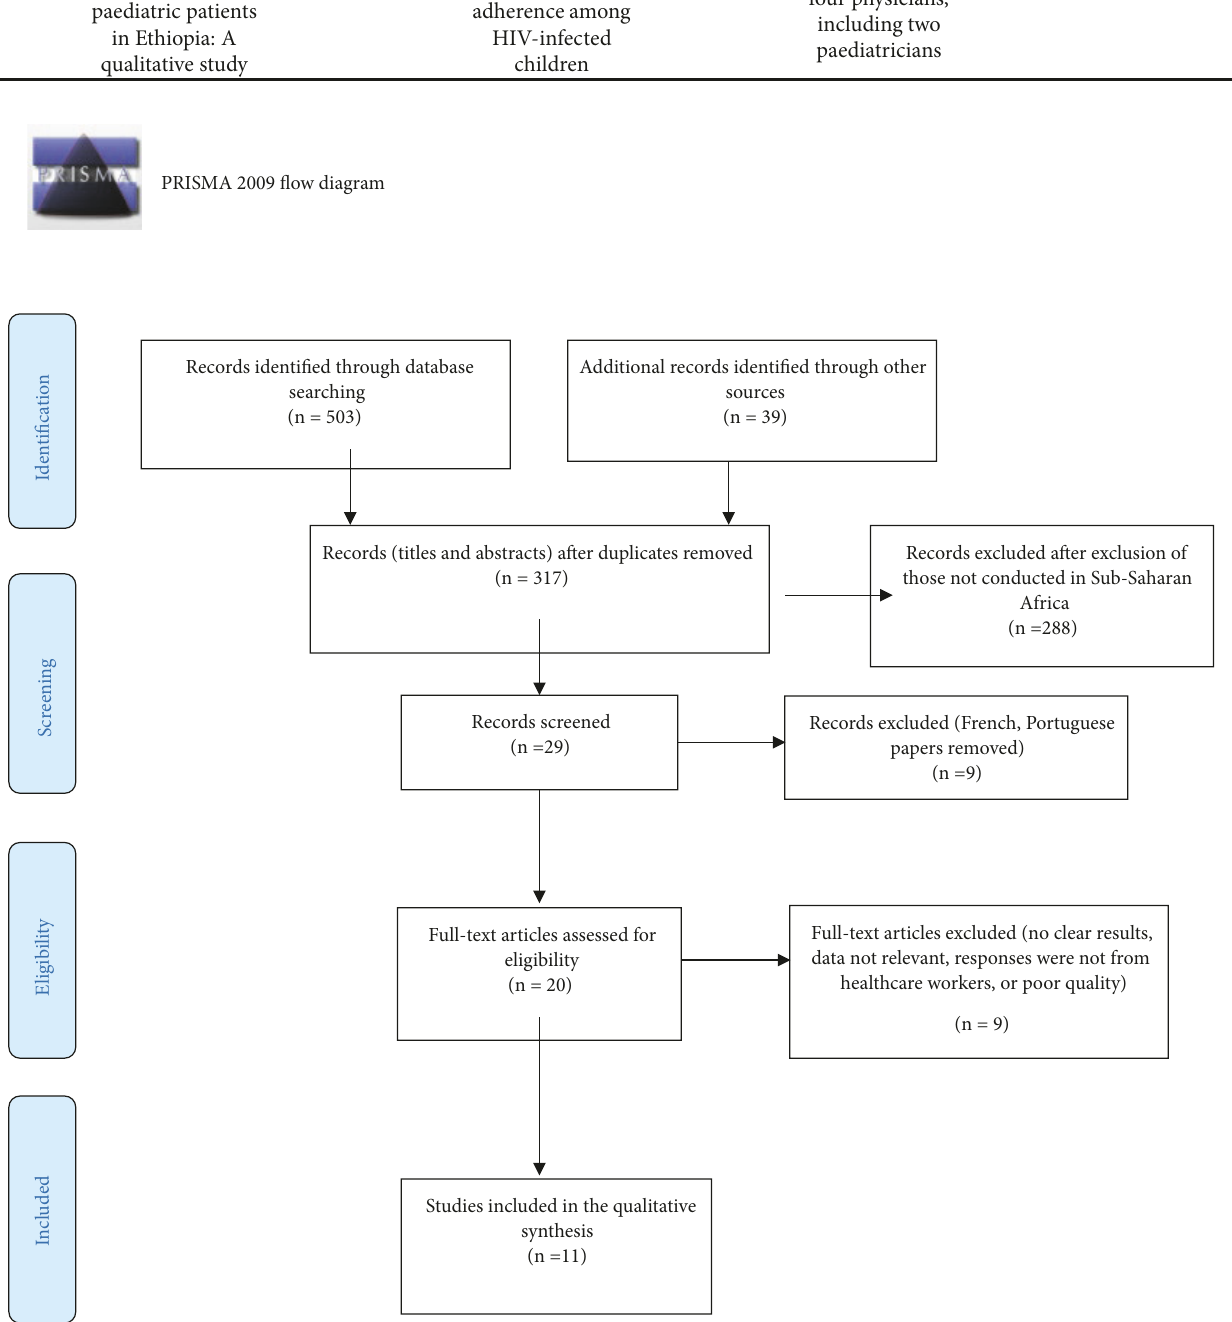
Figure 1: PRISMA flow